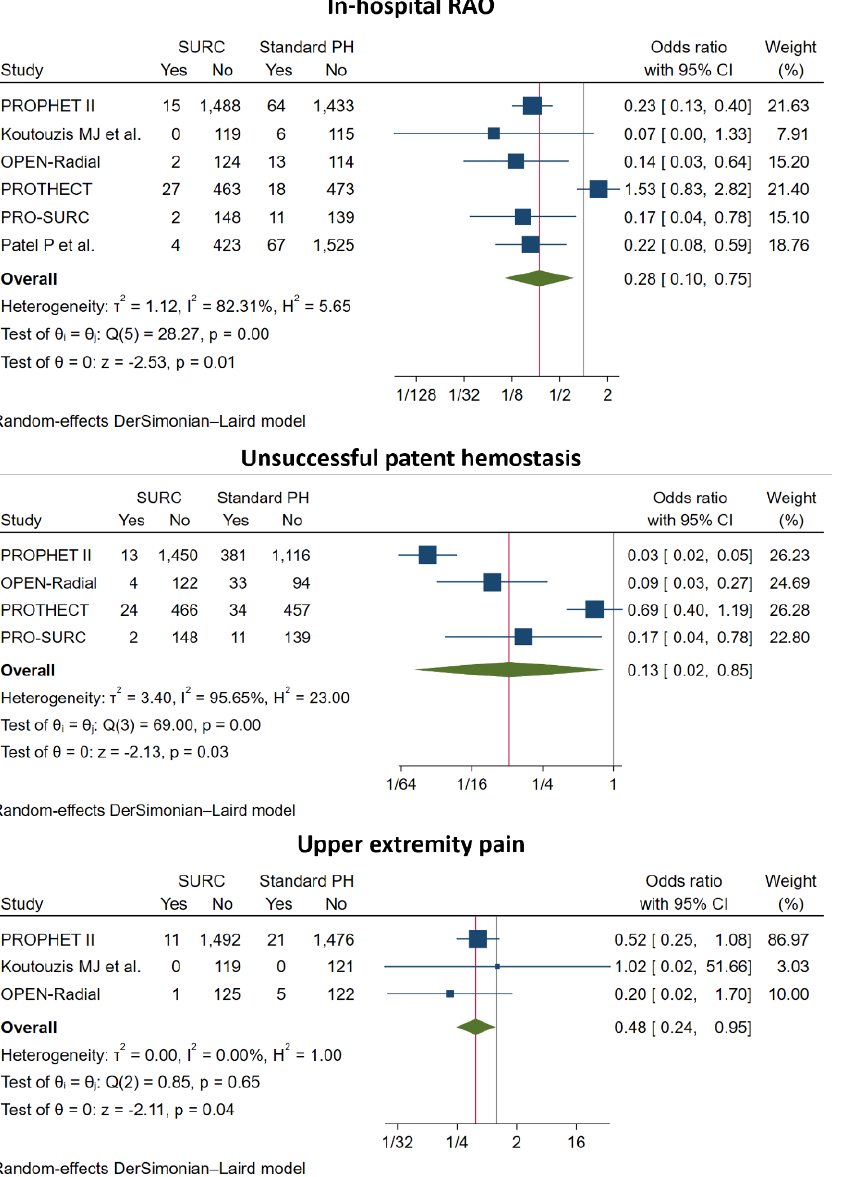
Figure 3. Pooled analysis of studies comparing simultaneous ipsilateral and ulnar artery compression versus isolated radial artery compression. Forest plot reporting trial-specific and summary odds ratios (OR) with 95% confidence interval (CI) for the endpoint of in-hospital radial artery occlusion (RAO), unsuccessful patent hemostasis (PH) and upper extremity pain.